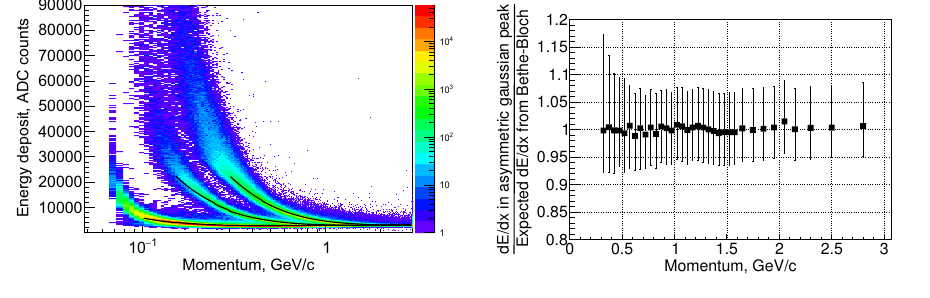
GeV/c0 0.5 Momentum, Figure 2: dE / dx quality